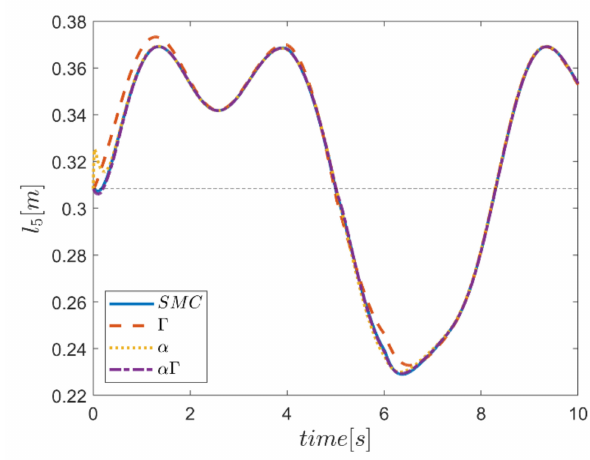
Figure 38. Comparison of the length of the fifth